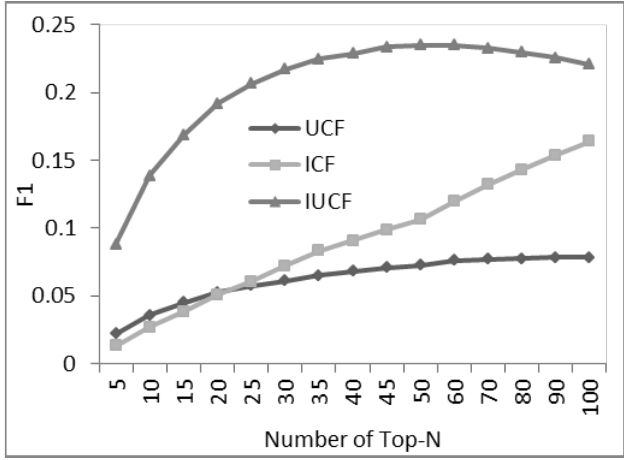
Figure 8. Comparison of F1 with Top- N changes.